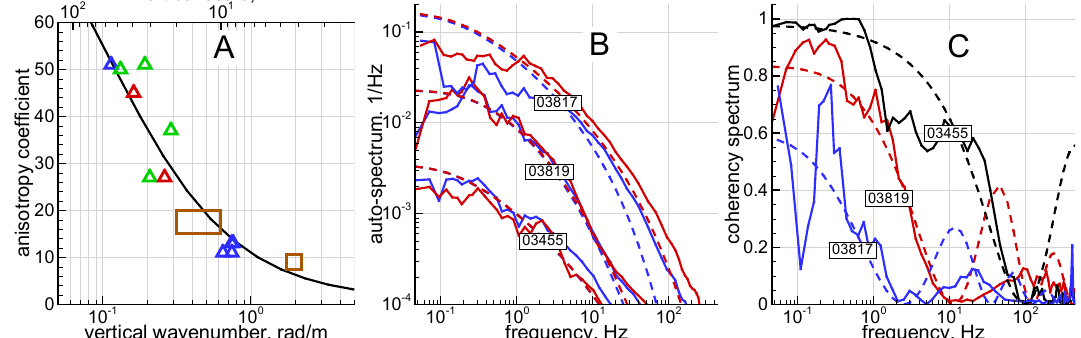
Figure 4. (A) the anisotropy coefficient. Experimental estimates are shown by triangles: blue for high latitude, green for mid-latitudes, red for tropics. Black line: approximation Eq. (5) of the experimental estimates. Brown square: the estimates of Gurvich and Kon (1993) using the angular dependence of backscatter radar signal for an altitude ∼ 20km; brown rectangle: the estimate of Kan et al. (2012) obtained from the analyses of chromatic scintillations of a double star for altitudes 30–38km. (B) : autospectra and (C) : coherency spectra of the anisotropic component. Solid lines: experimental spectra, dashed line: the fitted model spectra. The numbers in boxes are the orbit numbers.